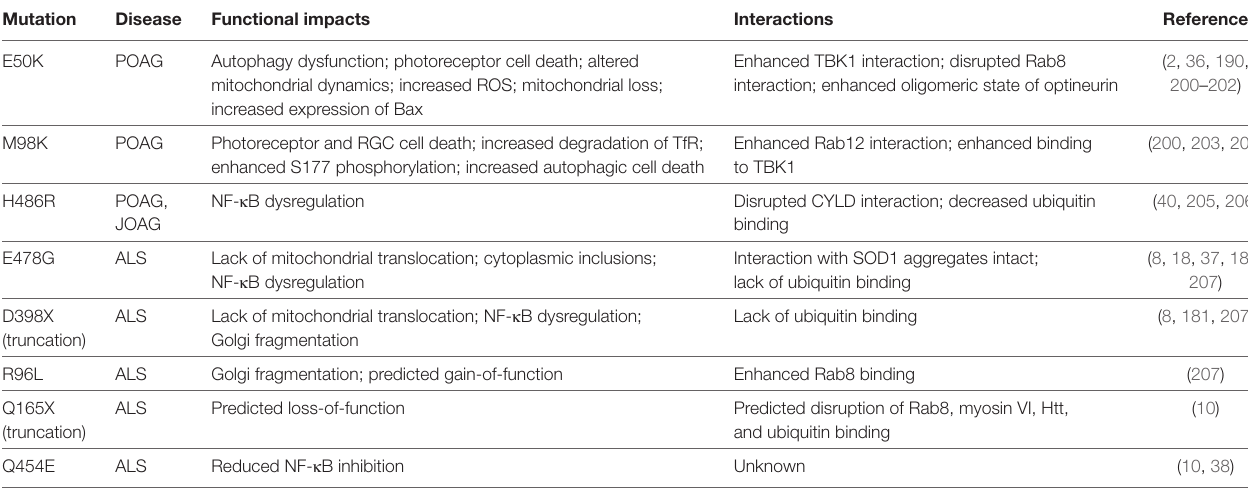
TABLe 1 | Identified and characterised optineurin mutants associated with POAG and ALS.